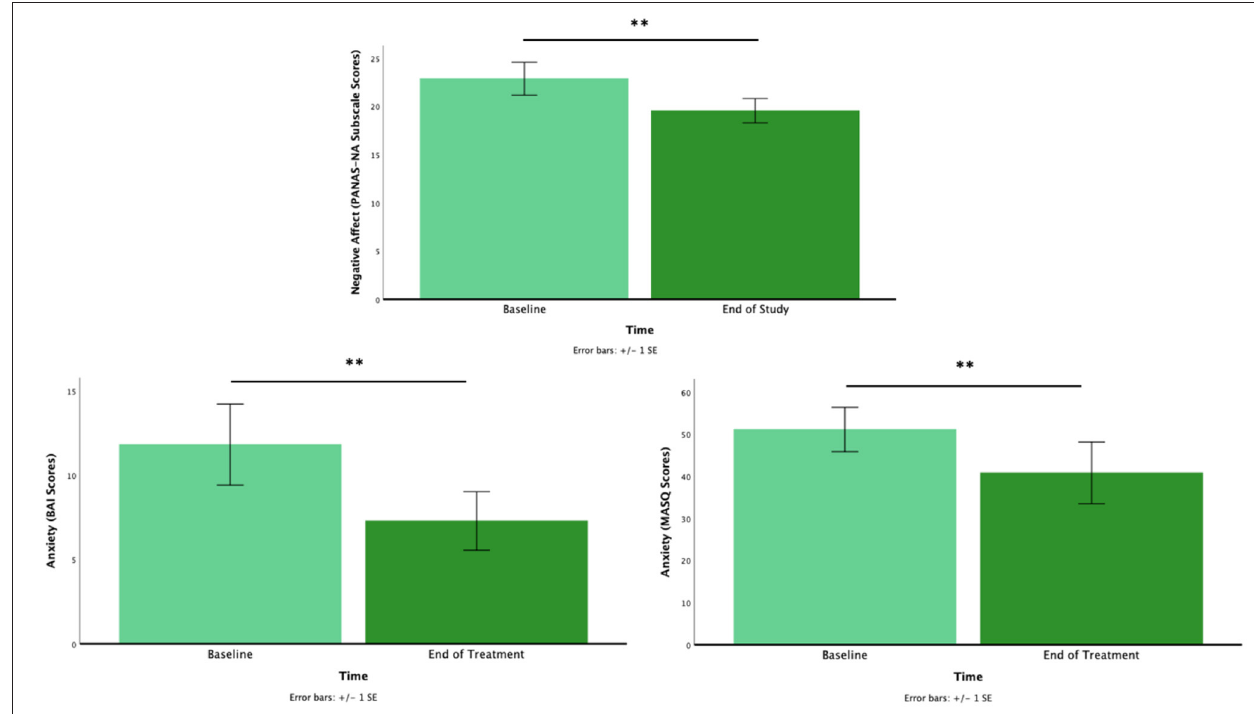
FIGURE 1 | The pre- to post-intervention for negative affect (top), anxiety for adults (bottom left), and anxiety for youth (bottom right). * p < 0.05, ** p < 0.01.